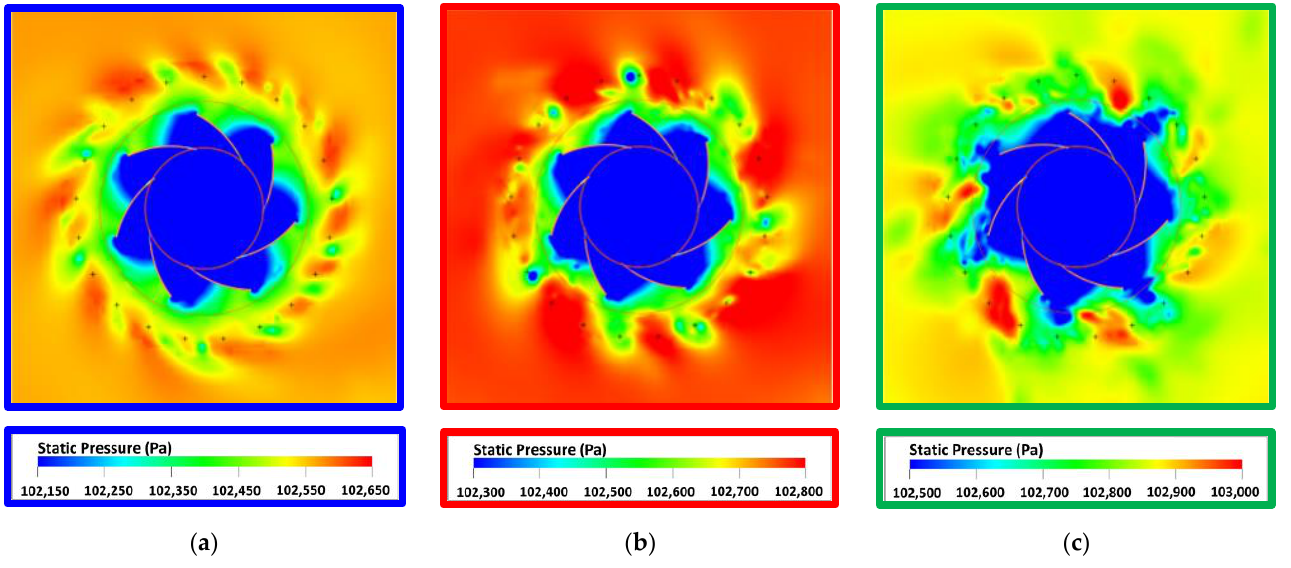
Figure 5. Instantaneous static pressure distributions at a plane cut in the middle between hub and rotating shroud (50% Span): ( a ) Q V = 4440 m 3 /h; ( b ) Q V =3500 m 3 /h; ( c ) Q V = 2500 m 3 /h.